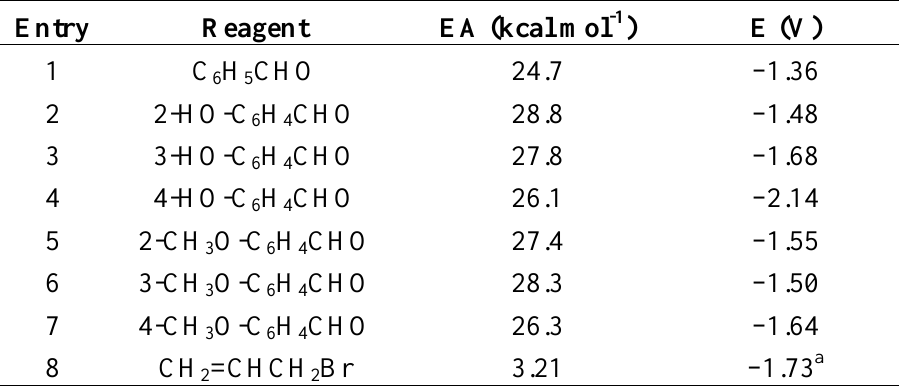
Table 4. Reduction potential (E) and electron affinity (EA) of substituted benzaldehydes and allyl